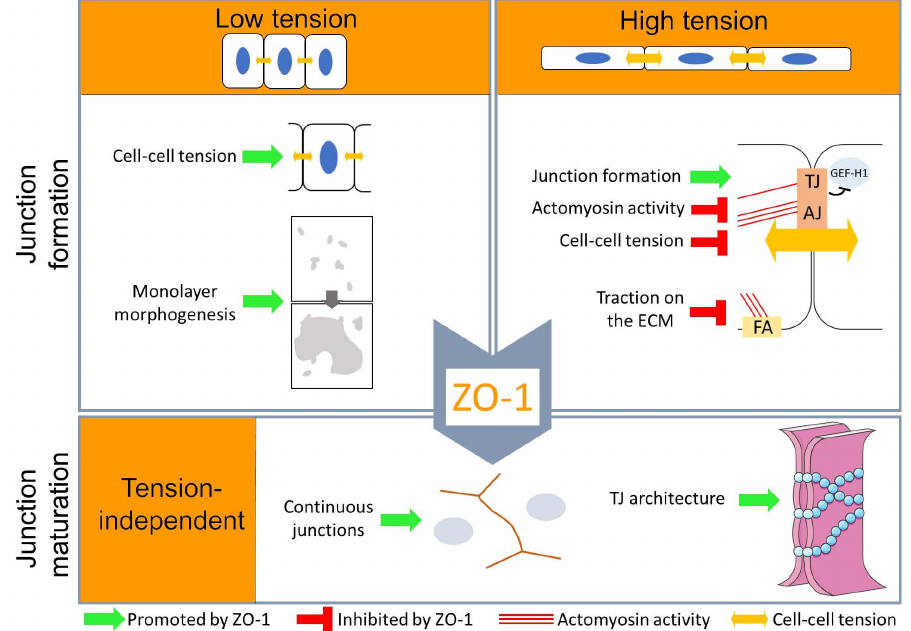
Figure 12. Schematic of the functions of ZO-1 during TJ assembly and epithelial morphogenesis. On soft ECM, ZO-1 is not required for assembly of functional barriers but regulates epithelial morphogenesis and cell–cell tension by tuning contraction and, thereby, epithelial sheet integrity. On stiff ECM, ZO-1 regulates contractility and ECM traction to control TJ assembly. In a second, tension- independent step, ZO-1 is required to assemble morphologically and structurally fully assembled TJ; in its absence, TJ remain only partially assembled and functionally altered.